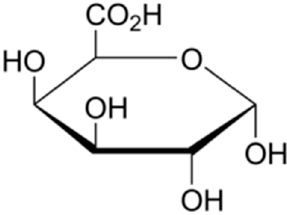
Figure 10. Structural formula of galacturonic acid, the main component of pectin [34].